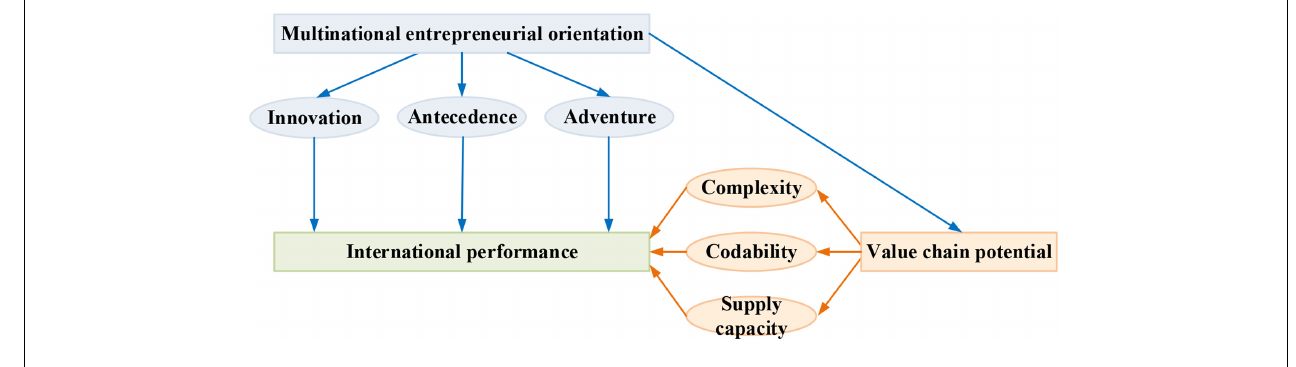
FIGURE 2 | Model of effect of the entrepreneurship international performance.